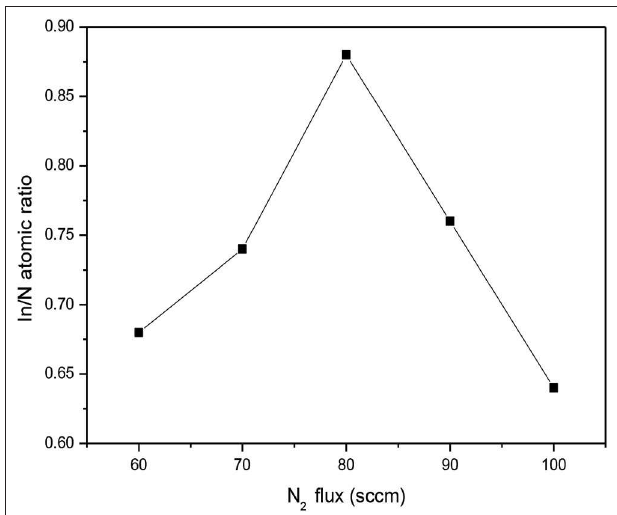
FIGURE 6 | The EPMA patterns of InN films at N 2 flux with 80 sccm.